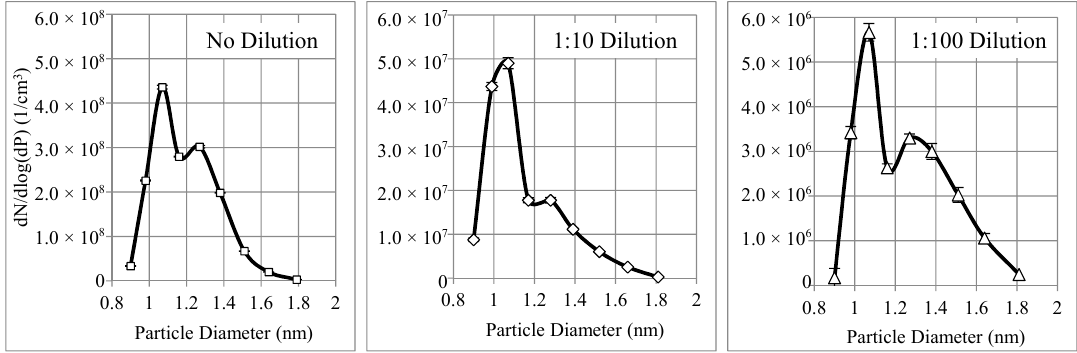
Figure 5. WO x nanoparticle number concentration distributions generated by the tungsten oxide generator at an aerosol flow rate of 4 lpm.